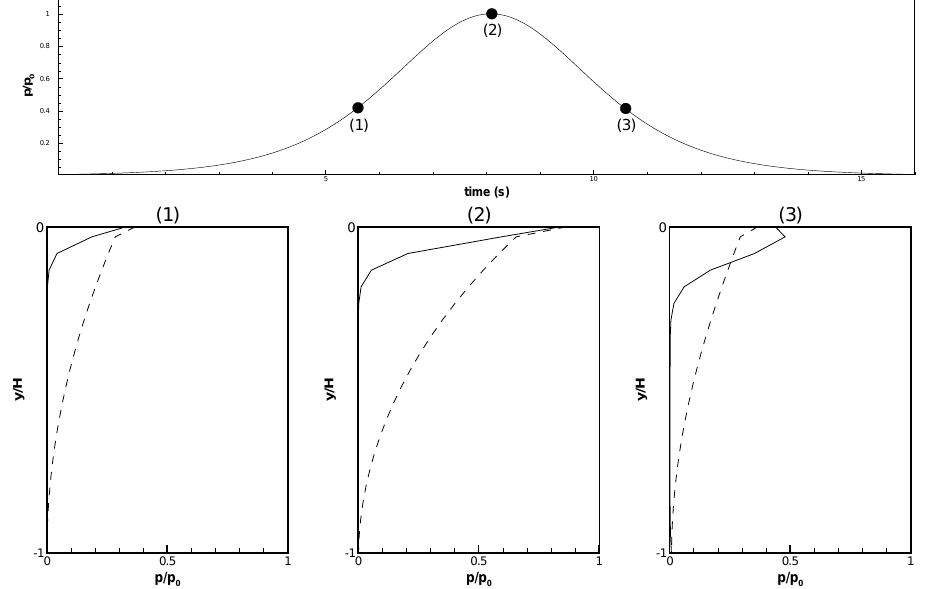
Figure 12. Distribution of excess pore-water pressure for permeability coefficient k = 1.0 × 10 − 4 m/s and various Young’s modulus: ——–, E = 1.0 × 10 4 kPa; − − − , E = 1.0 × 10 7